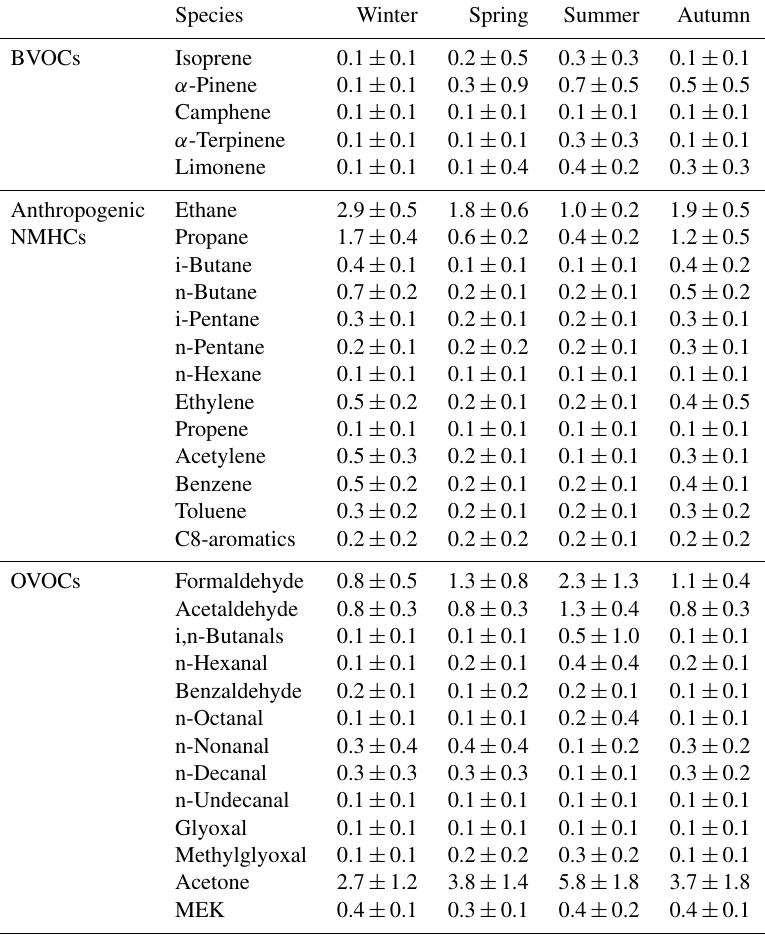
Table 4. Average VOC seasonal concentrations ( ± 1 σ ; µgm − 3